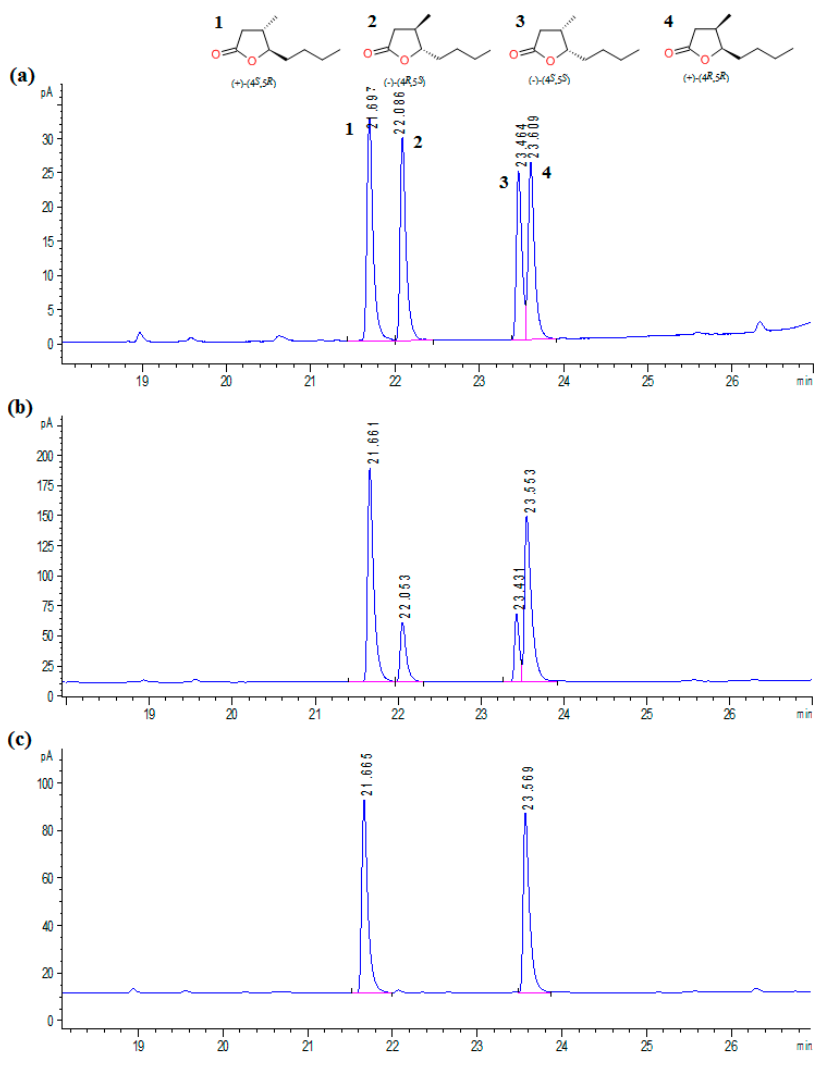
Figure 3. Chromatograms of substrate (racemate trans and cis whisky lactones) used for microbial kinetic resolution ( a ) and enantiomerically-enriched isomers of whisky lactones obtained before ( b ) and after the optimization process ( c ).